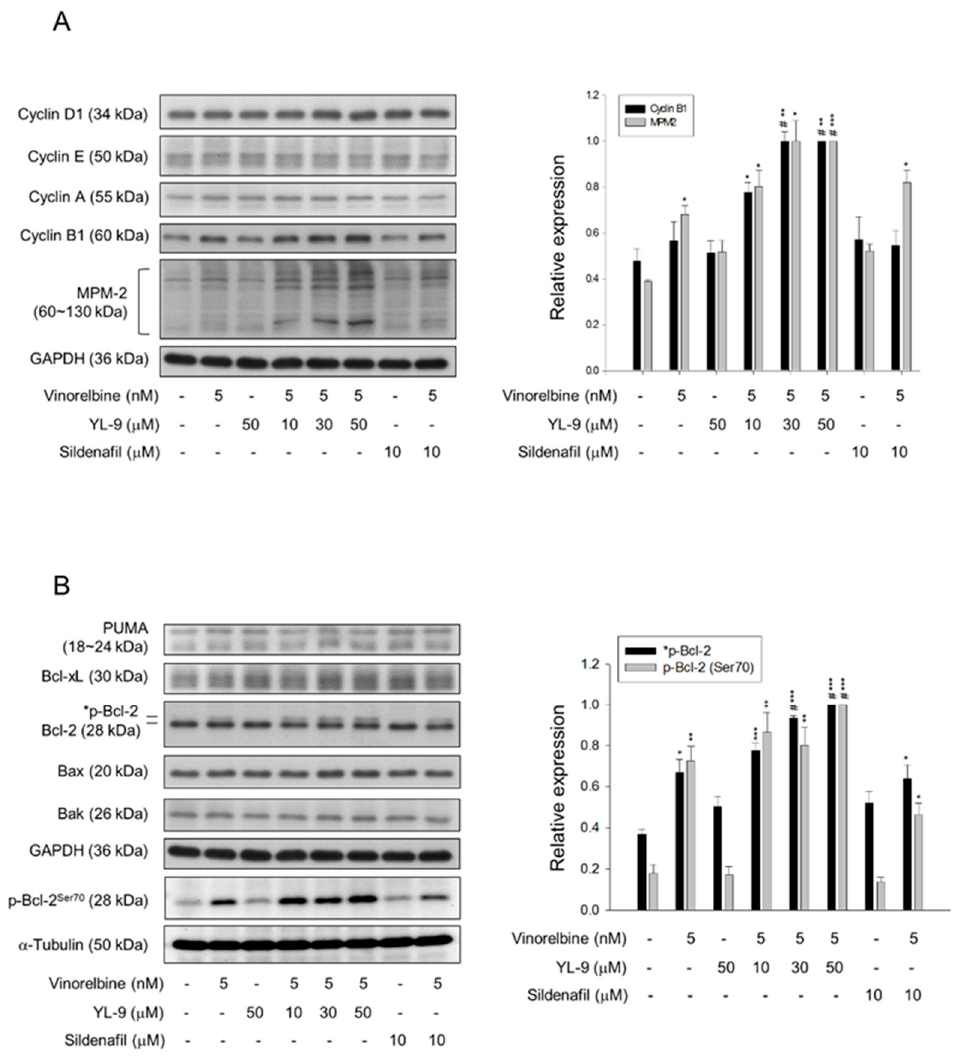
Figure 5. Effect of YL-9 on vinorelbine-induced alteration of several protein expressions. NCI-H460 cells were incubated with the indicated agents for 6 or 24 h. After the treatment, the cells were harvested for the detection of the expressions of cyclin proteins and phosphorylated mitotic protein ( MPM-2) ( A ) or Bcl-2 family members ( B ) using Western blotting analysis. The expression was quantified using Bio-Rad Image Lab TM Software. The expression is relative to the group of 5 nM vinorelbine/50 μ M YL-9. The images of internal control GAPDH are re-used in Figure 5A,B because they are the same experiment. Data are expressed as mean ± SEM of three independent experiments. * p < 0.05, ** p < 0.01 and *** p < 0.001 compared with the control. # p < 0.05 compared with vinorelbine